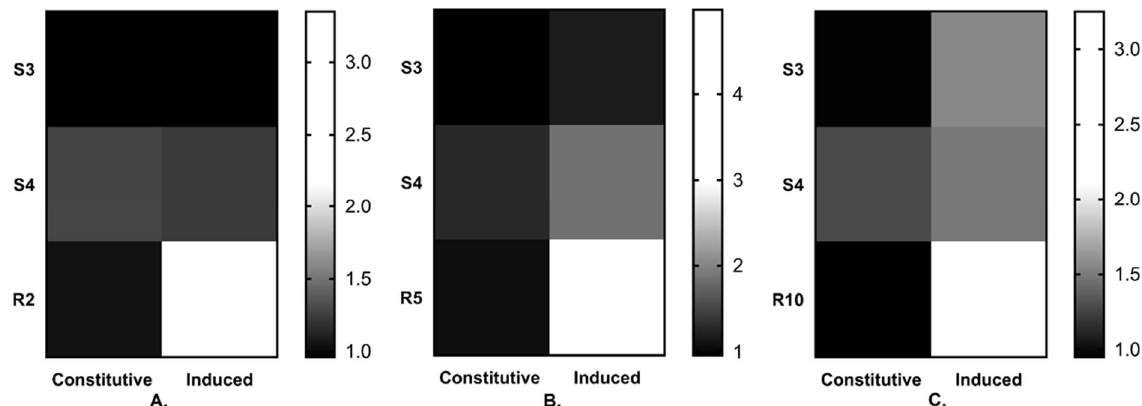
Figure 3. Analysis of gene expression variation of Cyp51 gene of Cercospora beticola . The gene expression values are in terms of 2 −ΔΔCt values. Constitutive and fungicide-induced over-expression under ( A ). Propiconazole treatment, ( B ). Prochloraz treatment and ( C ). Epoxiconazole treatment. In this figure, fungicide-exposed samples are termed as “induced”. “S stands for sensitive biotype and R stands for resistant biotype”.